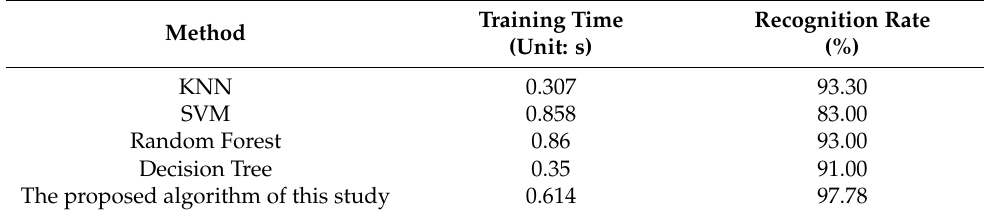
Table 6. The comparison results of the five kinds of